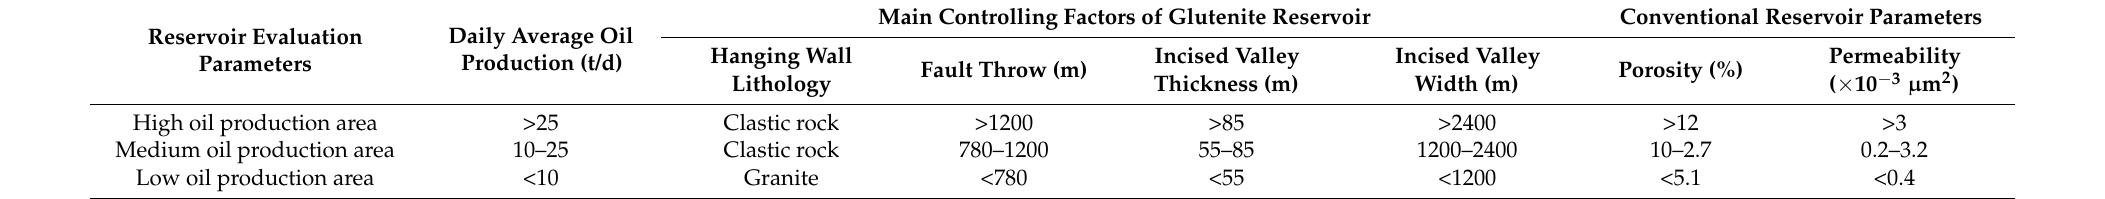
Table 7. Comprehensive evaluation standard of glutenite reservoir in the Guojuzi